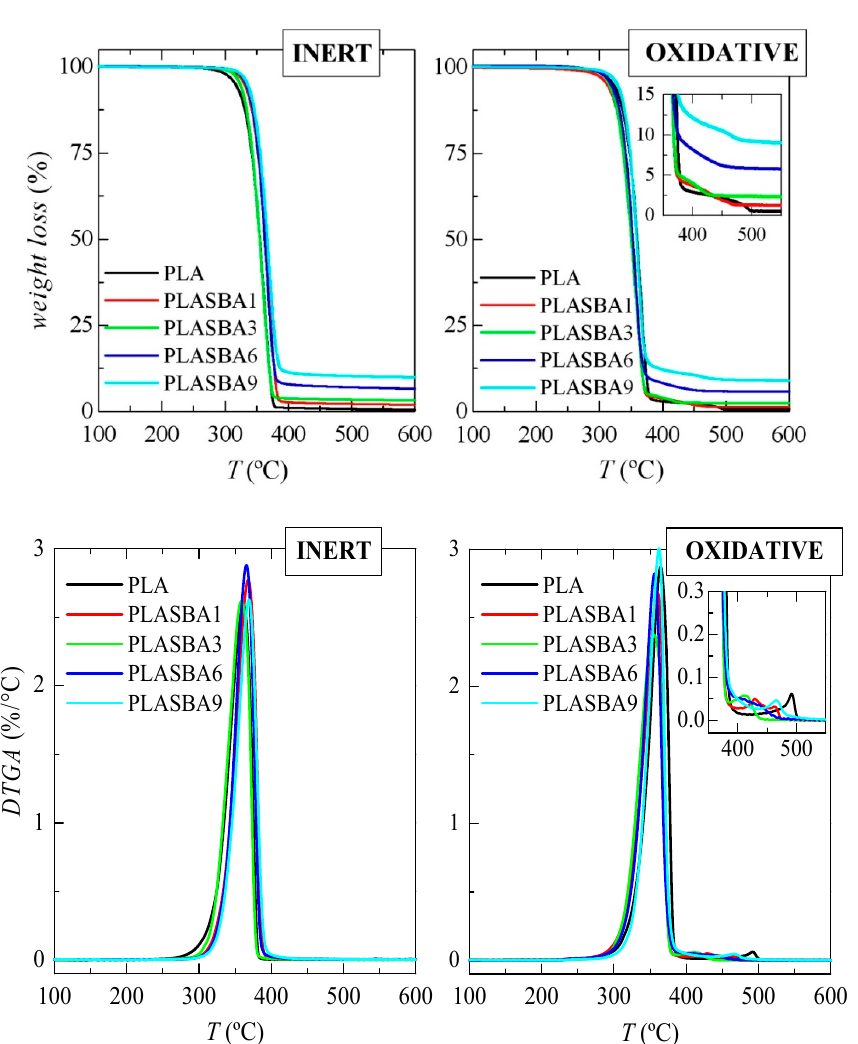
Figure 4. TGA curves under inert ( left ) and oxidative ( right ) atmospheres for the neat PLA and its composites with SBA-15 at different contents prepared by melt extrusion (top representations), as well as their corresponding derivative TGA (DTGA) curves (bottom representations).